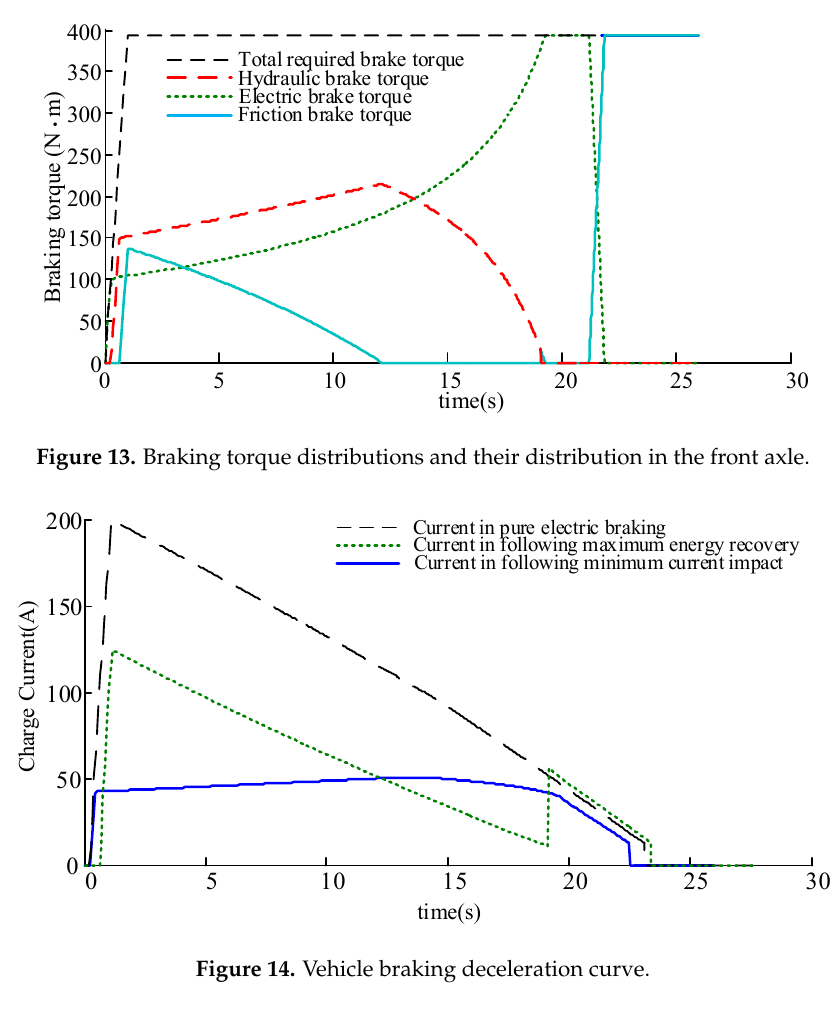
Hydraulic brake torqueTotal required brake torque Electric brake torque Friction brake torque Figure 12. Brake torque distribution and its variation in the front axle. The distribution of the various braking forces illustrates that the regenerative braking force provided almost the complete braking energy. As calculated from the simulation results, during the whole braking process, the hydraulic energy recovery rate is 43.4%, while the electric energy recovery rate is 50.8%. The total recovery rate is 94.2%. 6.2. Simulation Results by Following Minimum Current Impact Due to the restriction by the charge current, the electric motor could not provide the required braking force in the initial stage of the braking process. Therefore, both friction and hydraulic braking are required to feed the insufficient part. Figure 13 illustrates the distribution of various braking forces and their variation based on the minimum current impact principle. As depicted in the figure, at the beginning of the braking process, all the three braking forces are activated; first, electric braking, next, hydraulic braking, and finally, friction braking. As the electric braking force